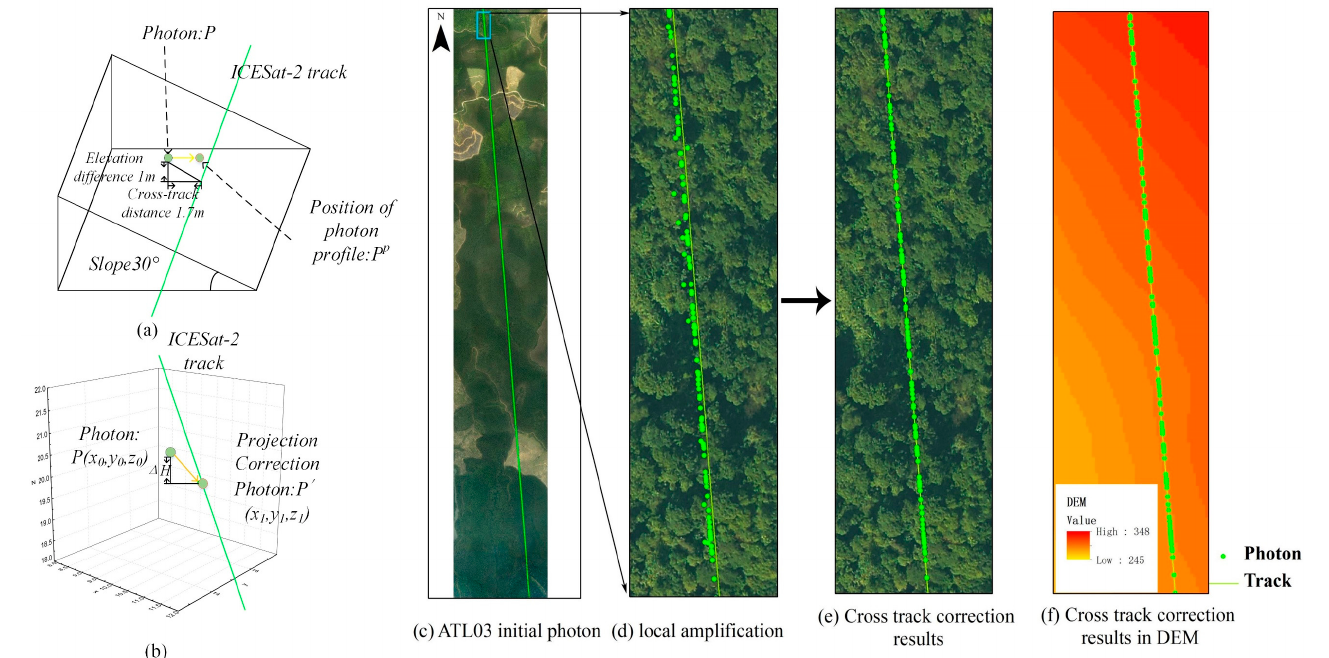
Figure 4. Schematic of the photon position before and after correction: ( a ) schematic of the cross-track photon error [47]; ( b ) schematic of correcting the cross-track photon error [47]; ( c , d ) positions of the initial photons; ( e ) photons after correction of ( d , f ) cross-track correction results for the ALOS PALSAR DEM.